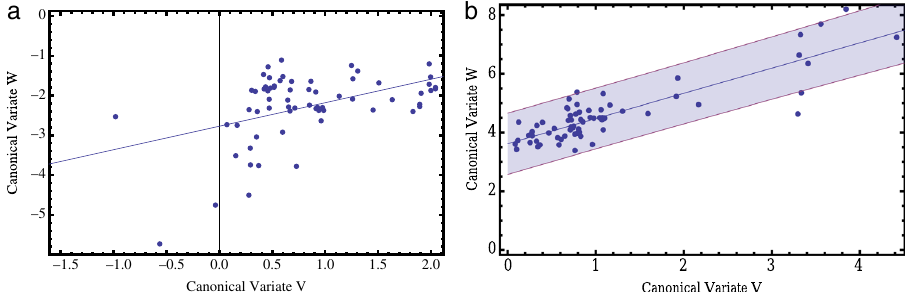
Fig. 2 a The canonical variates V and W identi fi ed by a canonical correlation analysis of the 68 data points from Application 1. The regression line is also shown. b The same as for part a, except that these results are obtained after Monte Carlo simulation. Also shown are the corresponding regression line and a 95% con fi dence interval for the data ( shaded region ). The correlation coef fi cient is 0.86